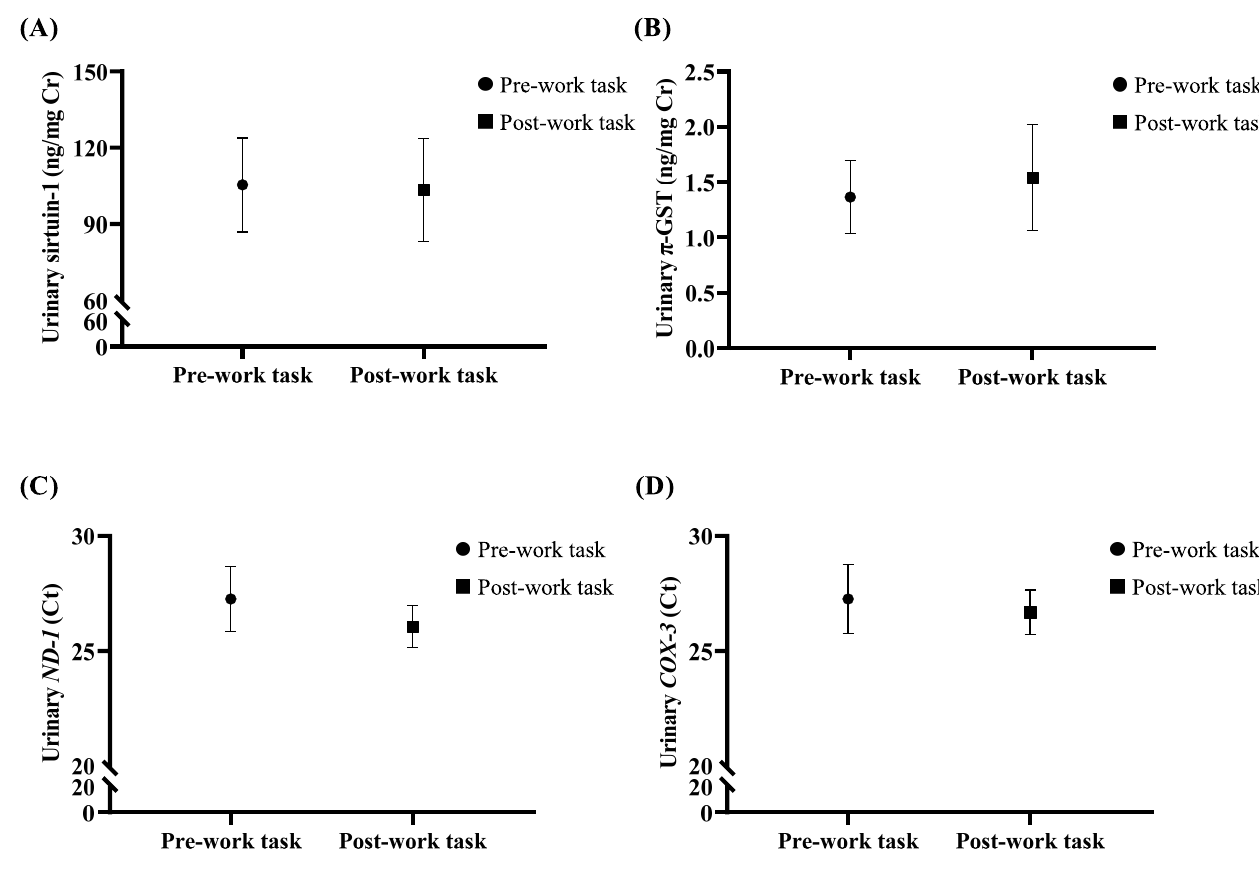
Figure 2. Comparison of urinary biomarkers ( A ) sirtuin-1, ( B ) π -glutathione S-transferase ( π -GST), ( C ) NADH-ubiquinone oxidoreductase chain 1 ( ND-1 ), and ( D ) cytochrome c oxidase subunit III ( COX-3 ) between pre- and post-work task urine sample. The data represented as median and 95% confidence interval. ng: nanogram; mg: milligram; Cr: creatinine; Ct: threshold cycle.